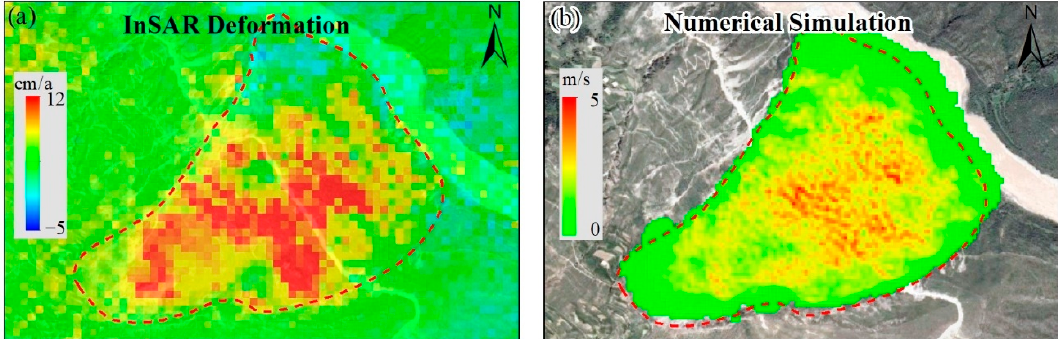
Figure 16. Comparison between InSAR deformation and the Xiaomojiu landslide’s dynamic process. ( a ) The average velocity of the landslide; ( b ) the average velocity of the first 5 s of the dynamic process.